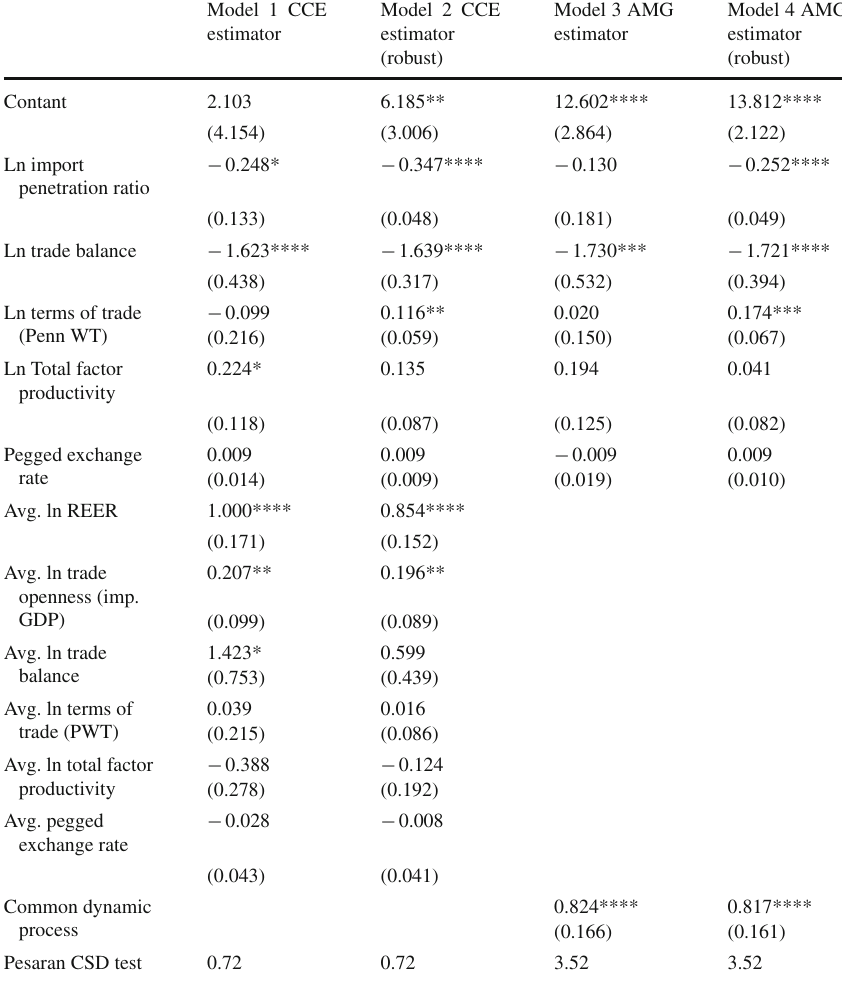
Table 3 CCE and AMG estimators regression (trade openness indicator: import penetration